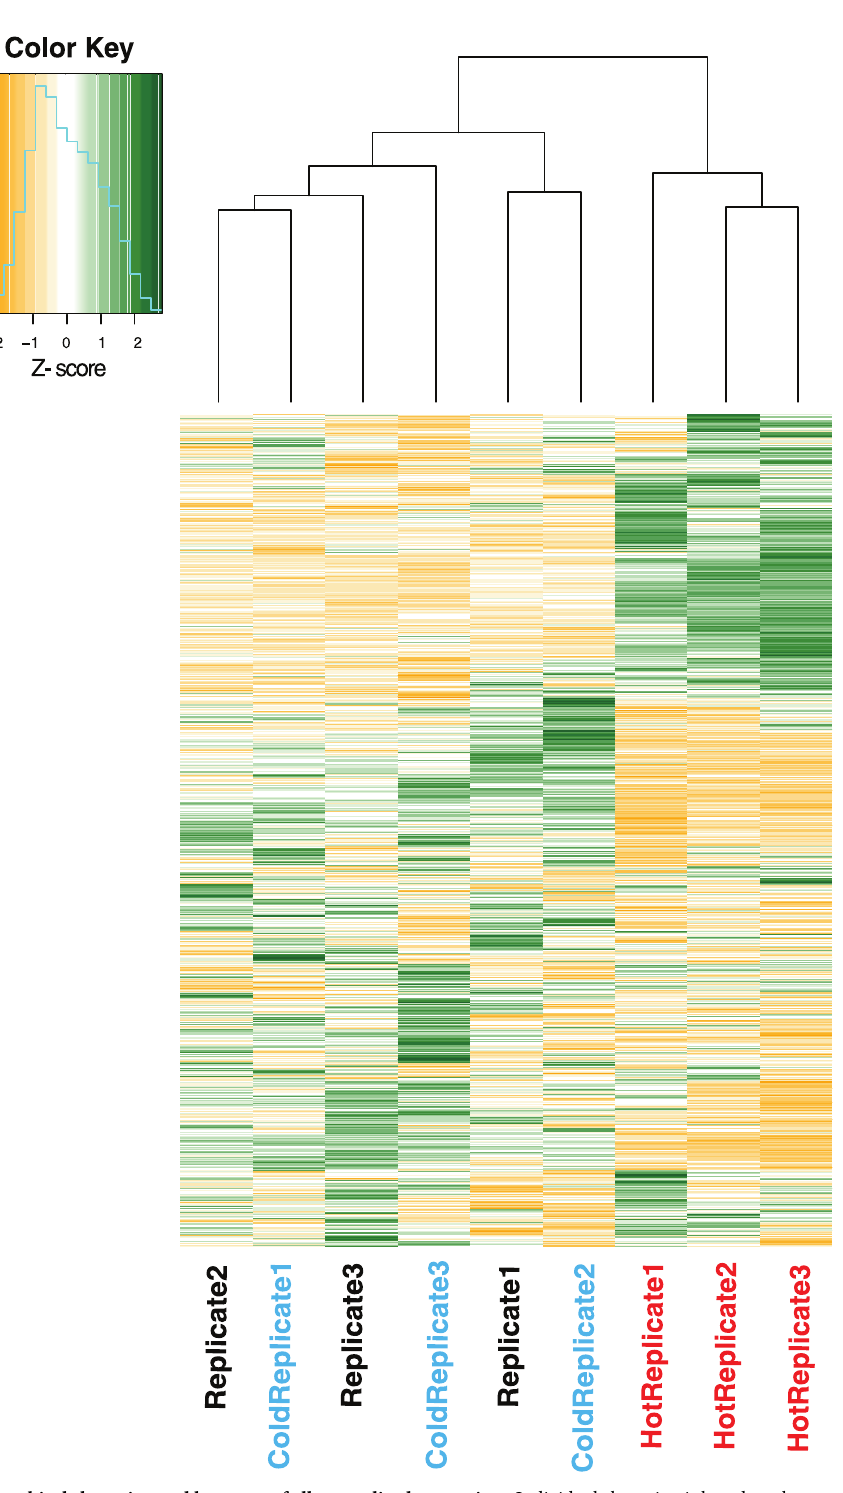
Fig 1. Hierarchical clustering and heatmap of all normalized transcripts. Individual clustering is based on the distance matrix of the similarities between samples. Colors indicate magnitude of change of expression indicated by the z-score calculated from individual transcript levels per gene. Upregulation of a gene is indicated in green, and downregulation is indicated in orange. Individuals are listed at the bottom of the heat map and color coded to indicate their treatment: red = heat-stressed, blue = cold-stressed, black = control.